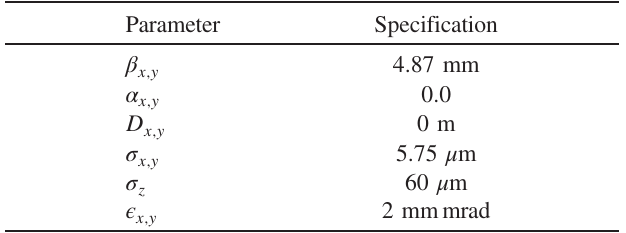
TABLE II. Specification for the bunch parameters at the injection point of the AWAKE Run 2c witness transfer